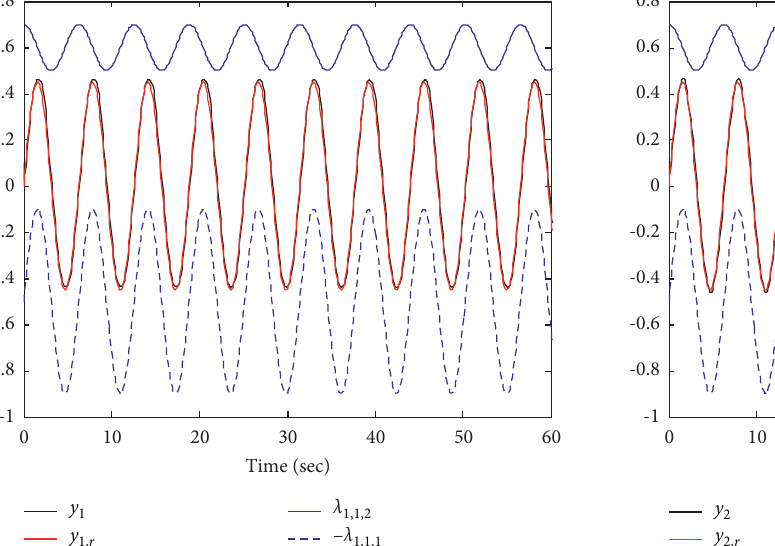
and reference signals y 1